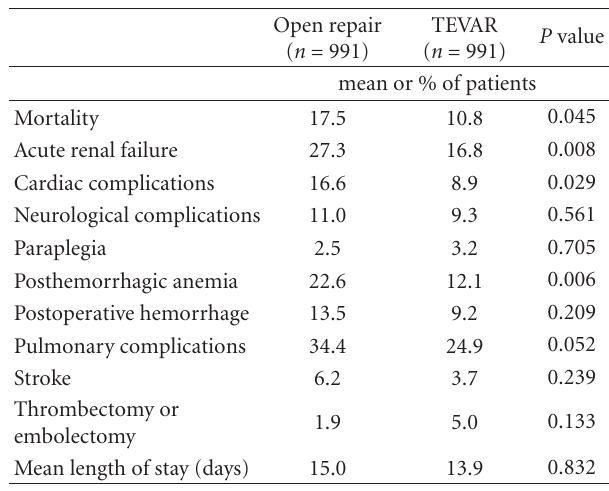
Table 4: In-hospital outcomes after open repair or TEVAR in a matched cohort of emergently admitted patients.